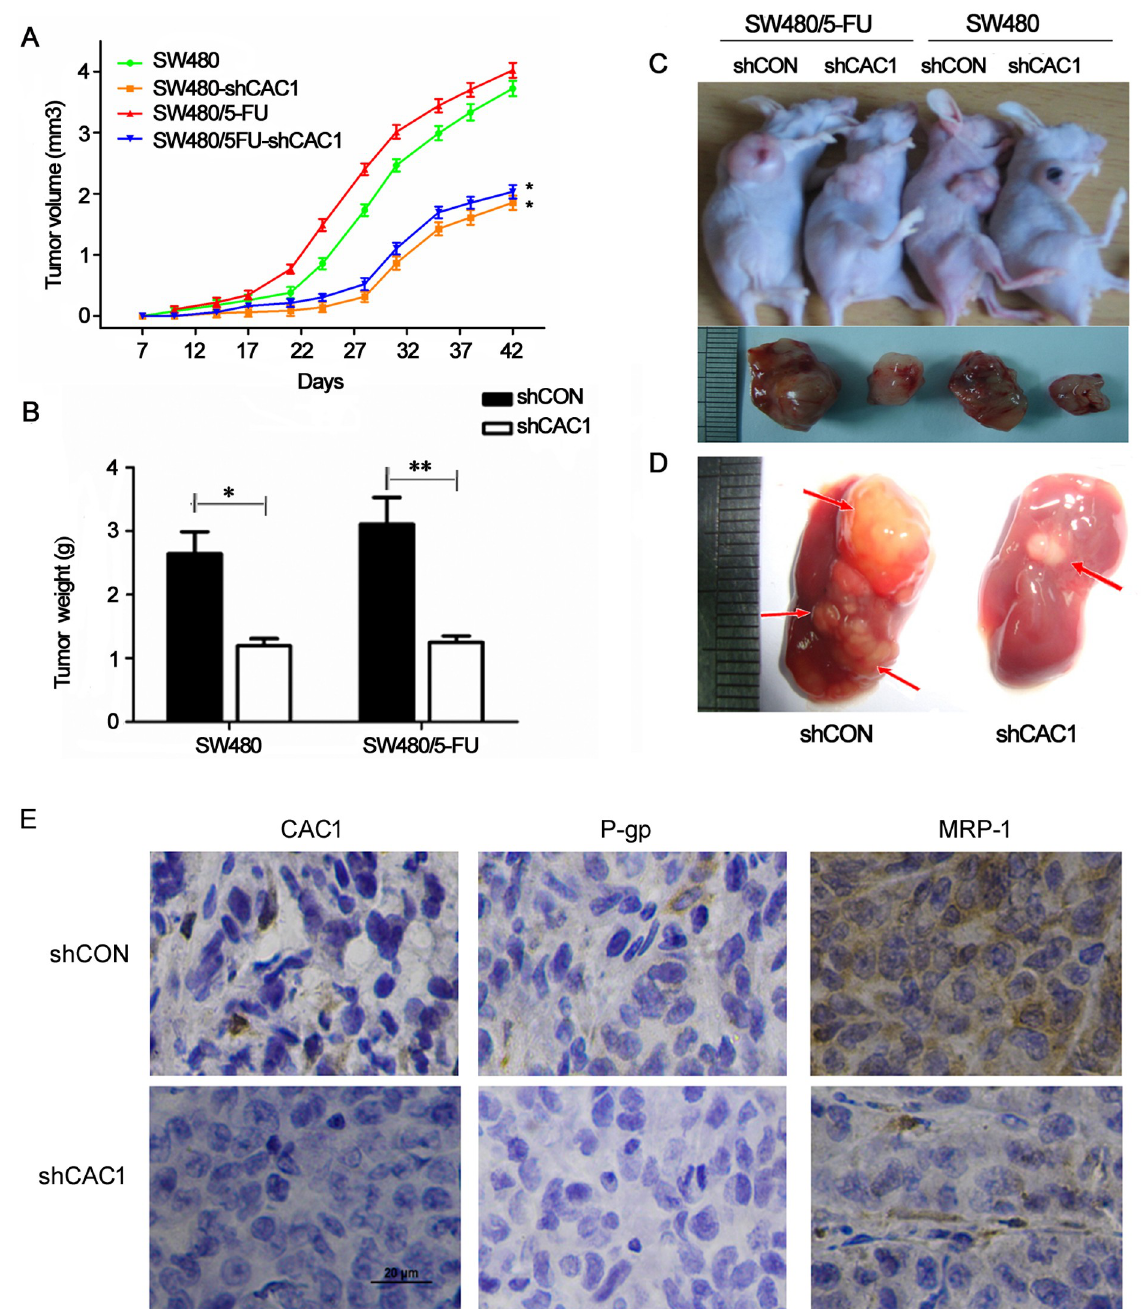
Fig 8. CAC1 knockdown reduced the growth of SW480/5-FU cell xenografts and liver metastatic lesions in vivo . (A) Tumor growth curve and (B) tumor weight in each group. (C) Representative photographs of tumors and (D) liver metastatic lesions isolated from nude mice in each group at six weeks after inoculation with SW480-shCON, SW480-shCAC1, SW480/5FU-shCON and SW480/5FU -shCAC1. (E) The levels of CAC1, P-gp and MRP-1 in transplanted tumors were detected by IHC. The expression of CAC1, P-gp and MRP-1 was lower in SW480/5FU-shCAC1 transplanted tumors, when compared to the SW480/5FU-shCON group. � P < 0.05, �� P < 0.01.